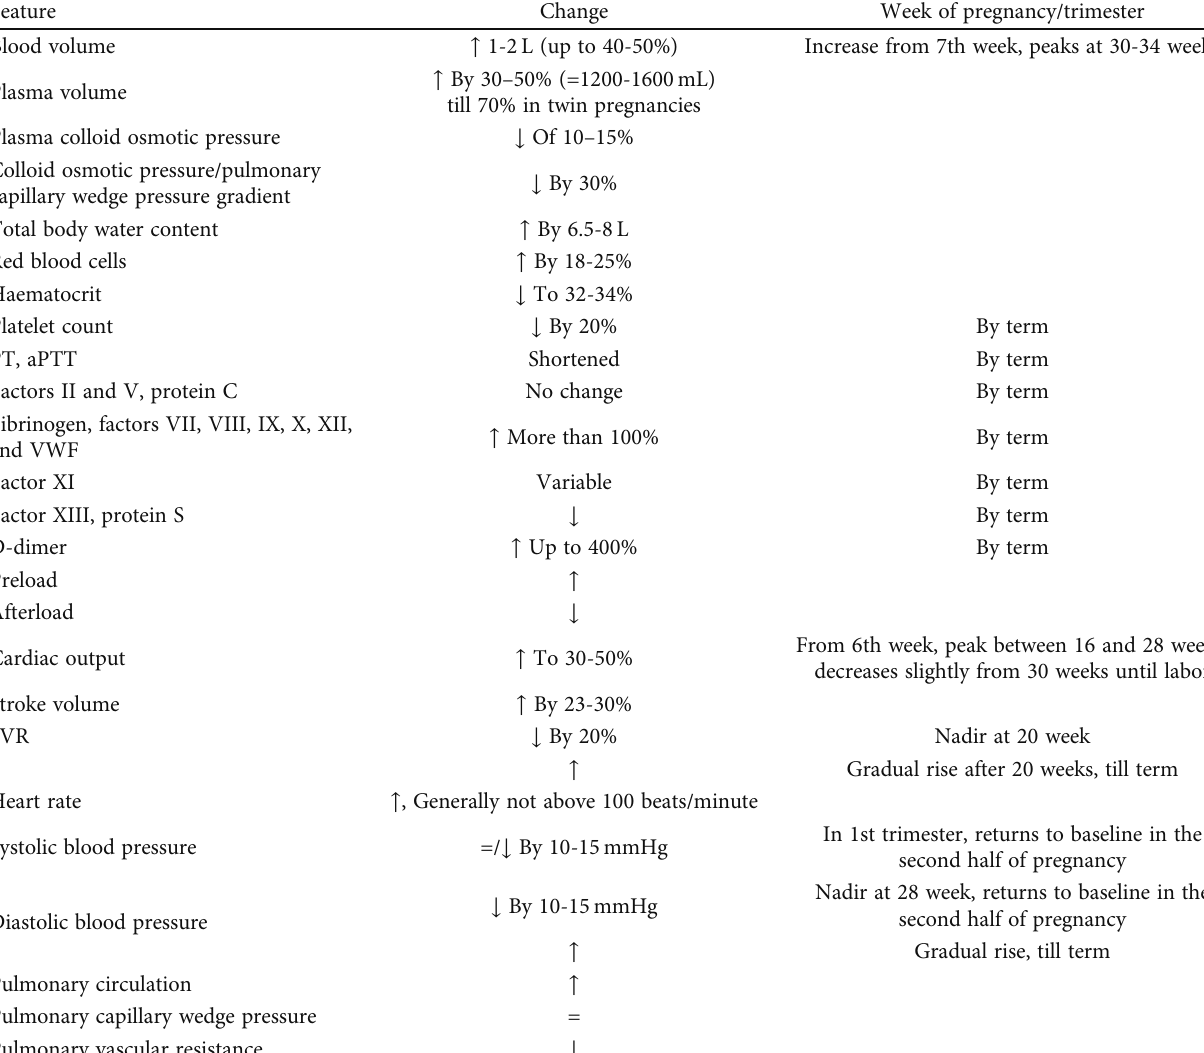
Table 2: Physiological changes of the cardiovascular system during the pregnancy [28 –